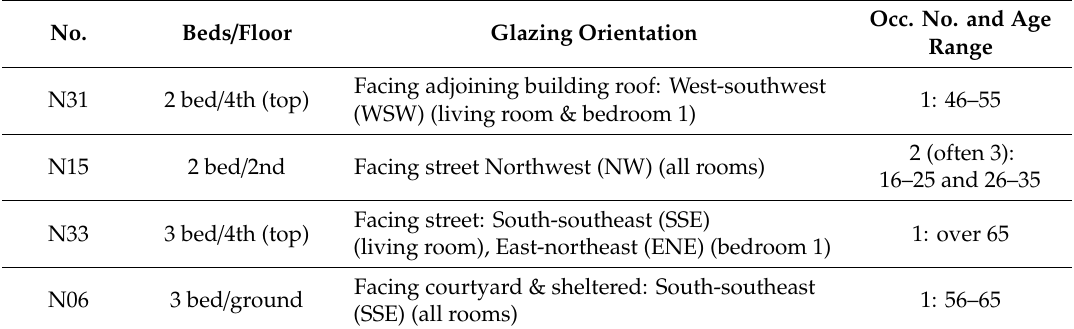
Table 3. Case study occupancy details (in order of increasing total floor area).